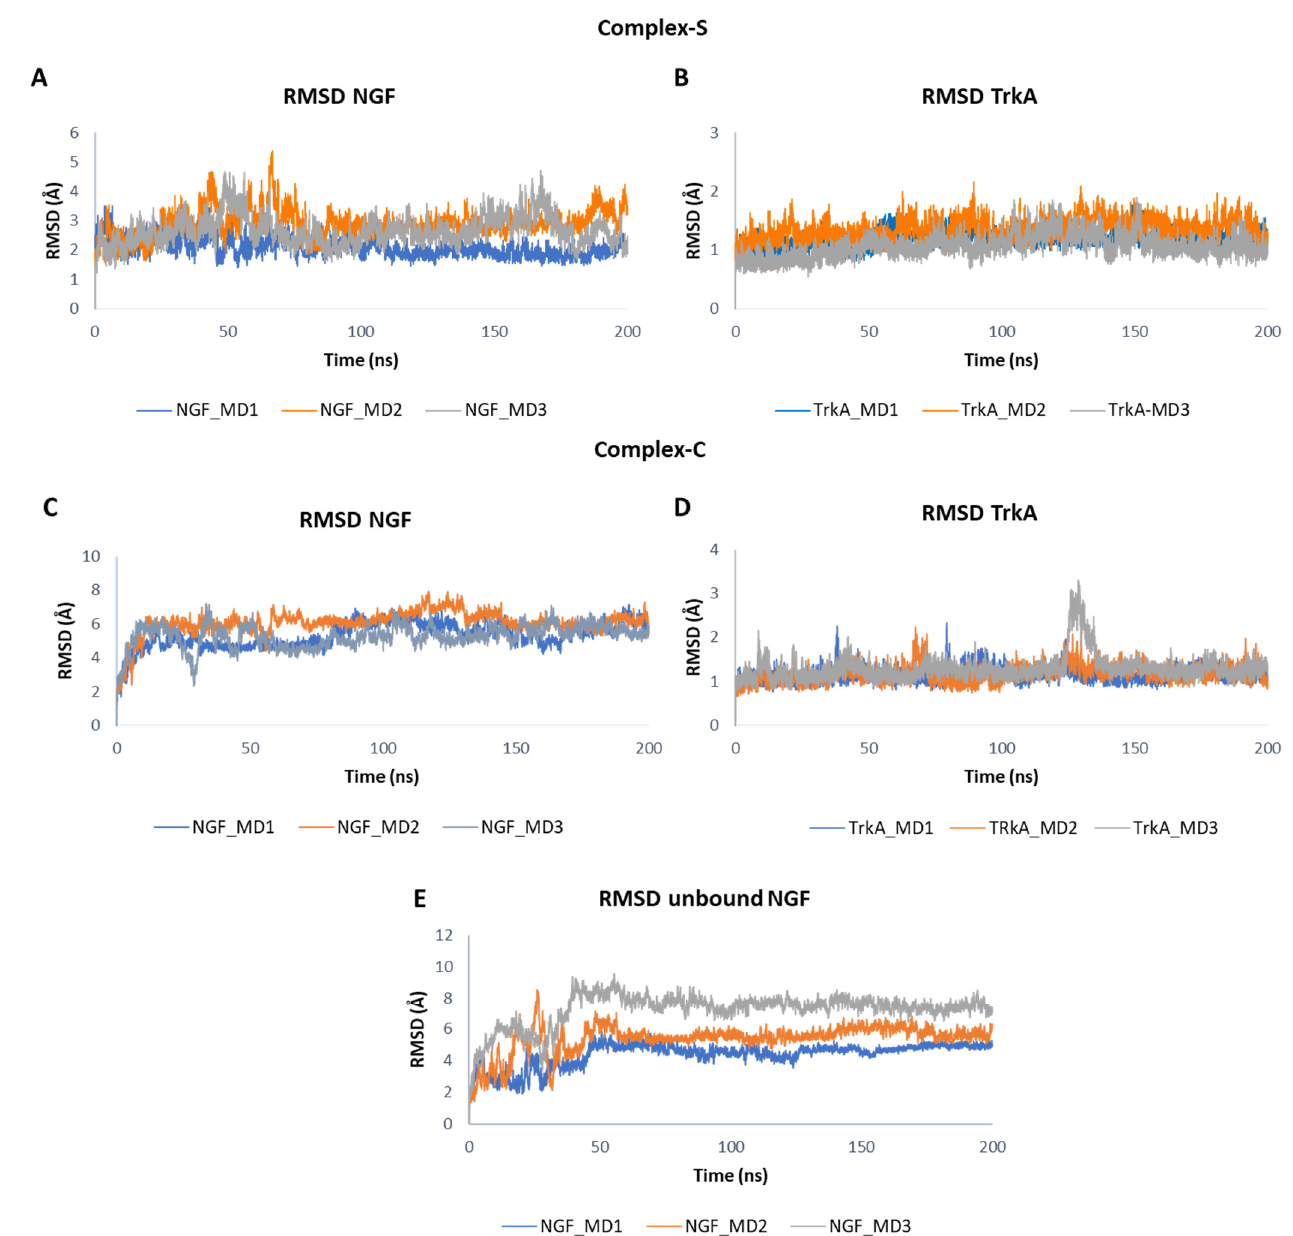
Figure 4. RMSD plots of NGF and TrkA backbones registered in the three MD runs performed on complex-S ( A , B ), complex-C ( C , D ) and the unbound NGF ( E ).